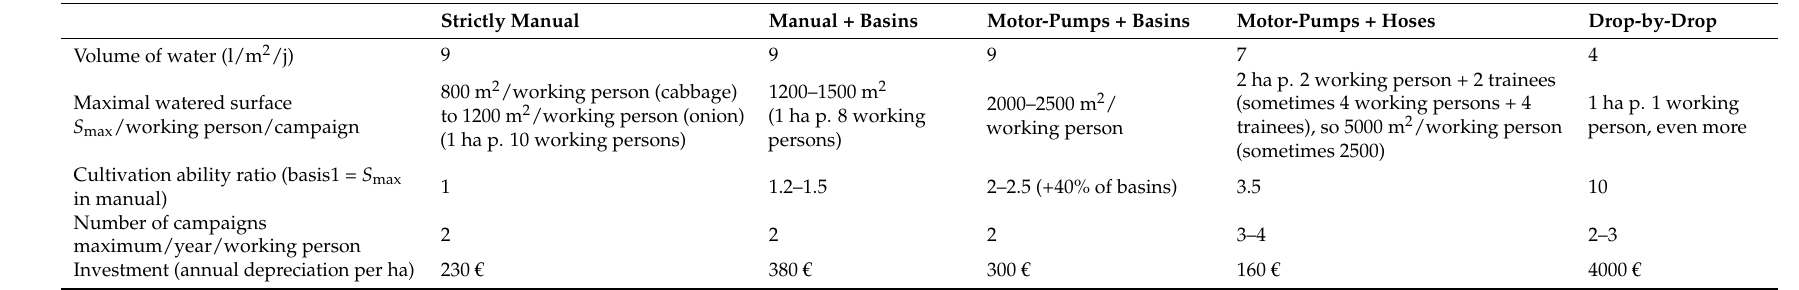
Table 5. Comparative performance of the various irrigation methods used in the Niayes.